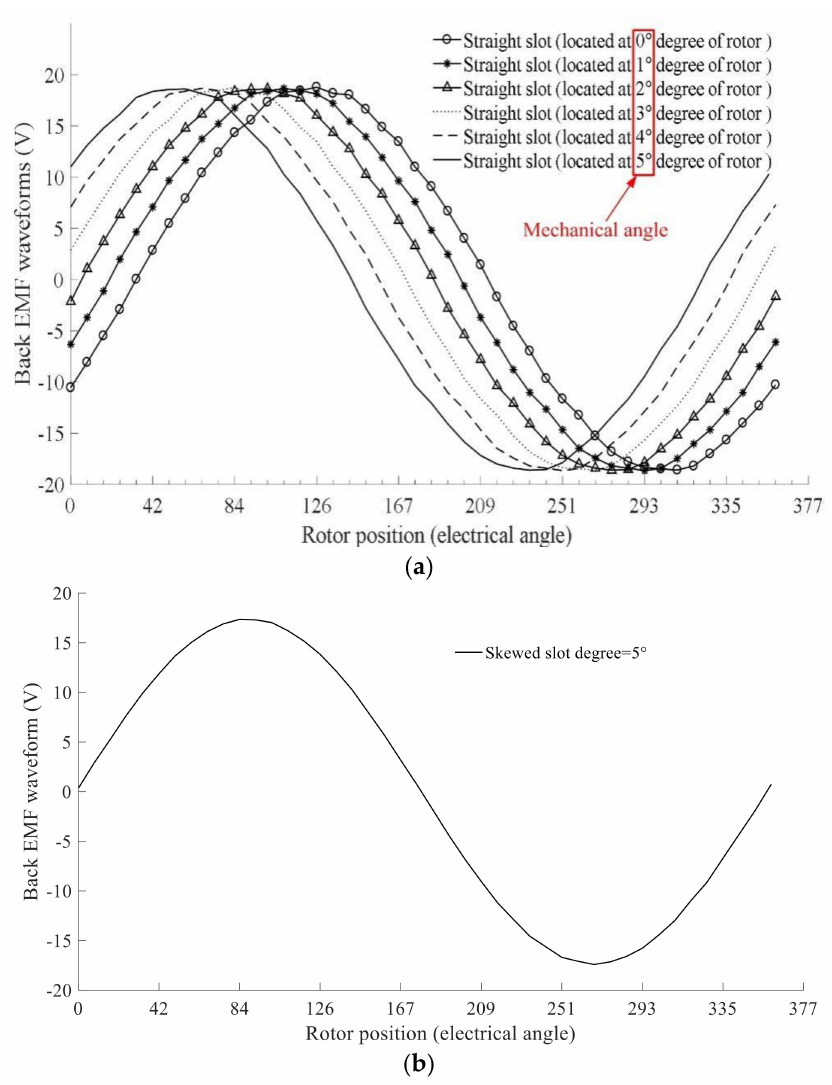
Figure A1. The back EMF waveform of the VFMPM machine (weakened flux condition). ( a ) Rotor straight slot type (straight slot located at different mechanical degree of rotor); ( b ) Rotor skewed slot